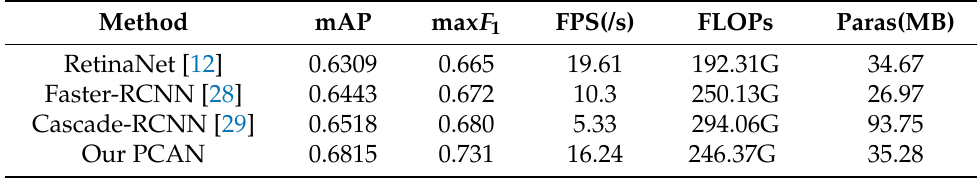
Table 3. Performance of different methods for TPP detection.